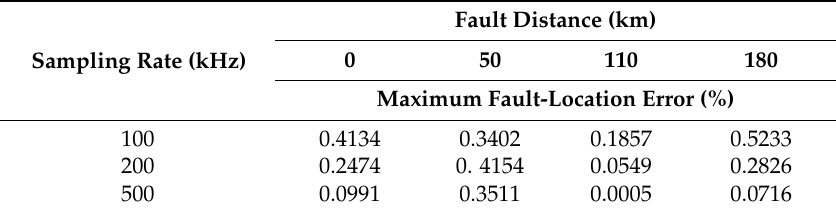
Table 4. Fault-location errors for PG faults with a fault resistance of 100 Ω at different locations, considering the influence of the sampling rate.